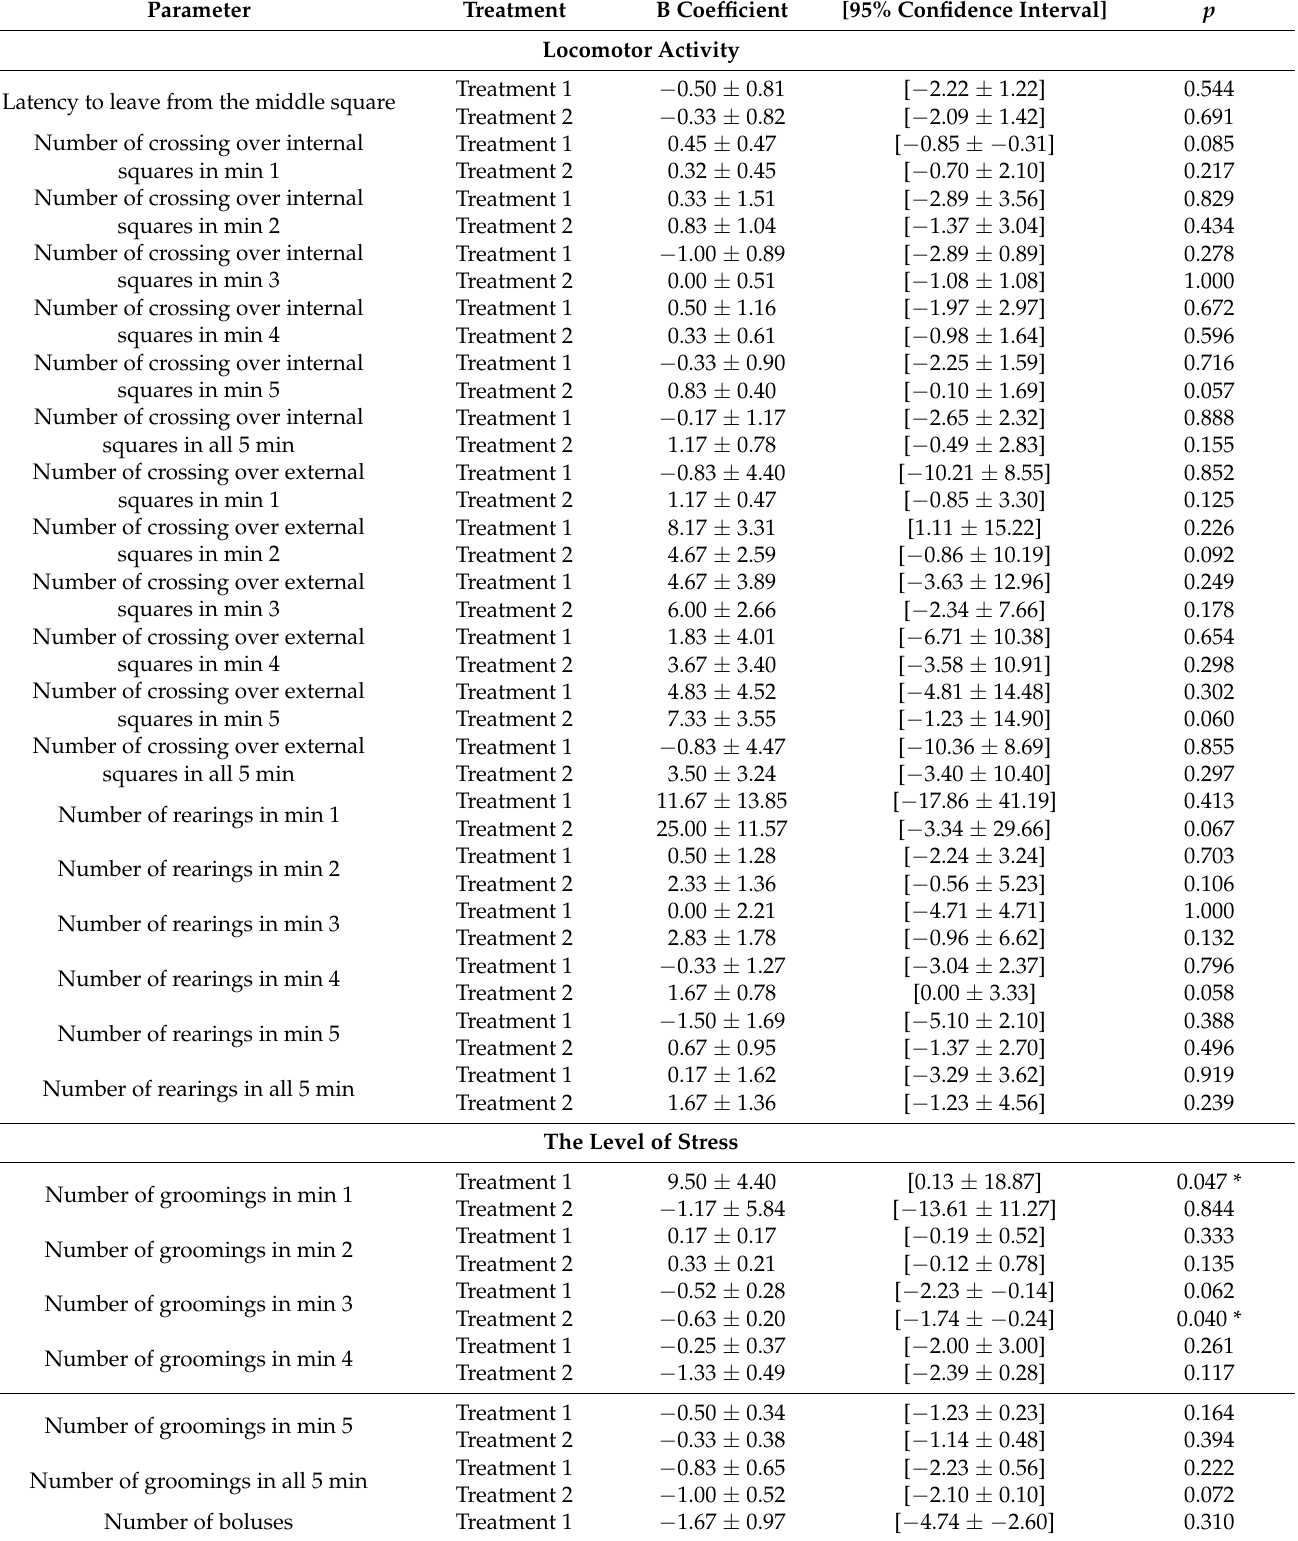
Table 2. Regression analysis of each treatment group compared with the control